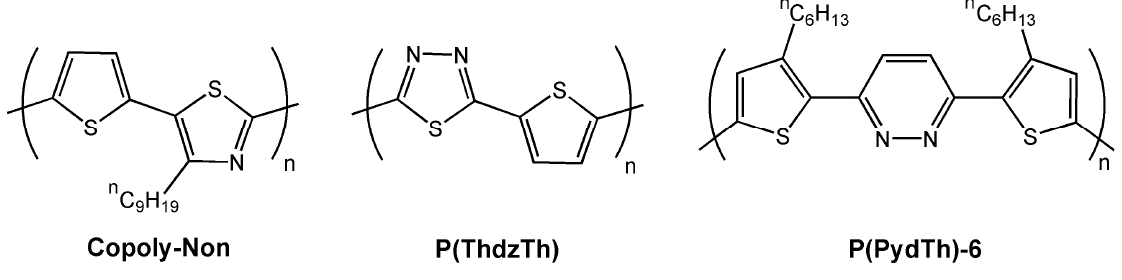
Figure 7. Chemical structures of some copolymers for field-effect